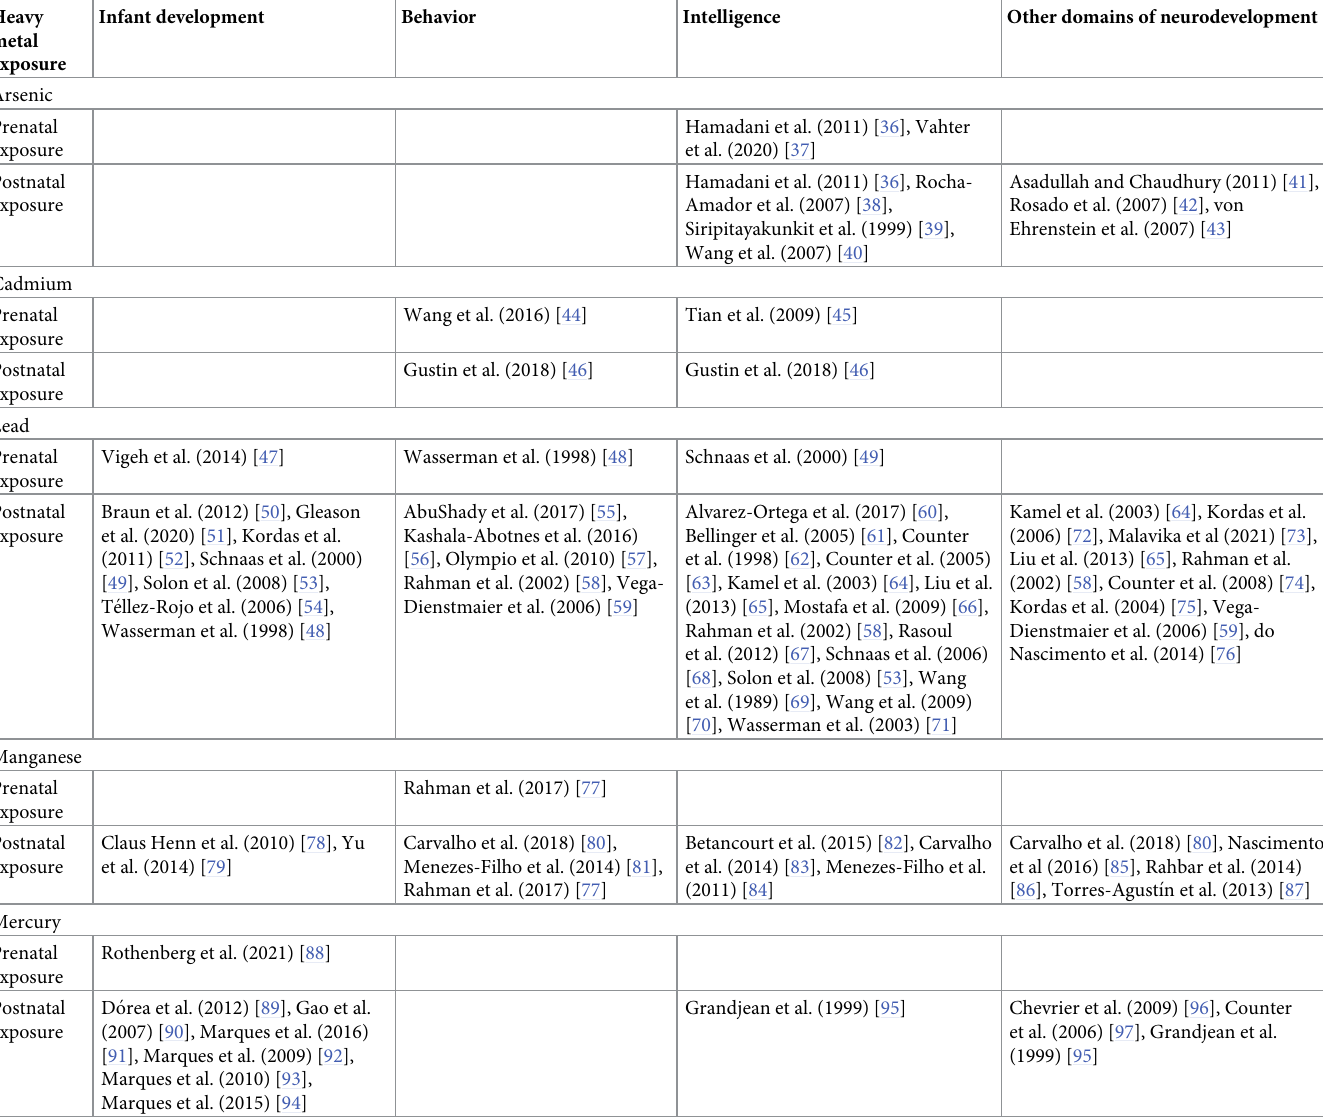
Table 1. Studies that found a negative association between heavy metal exposure and various domains of